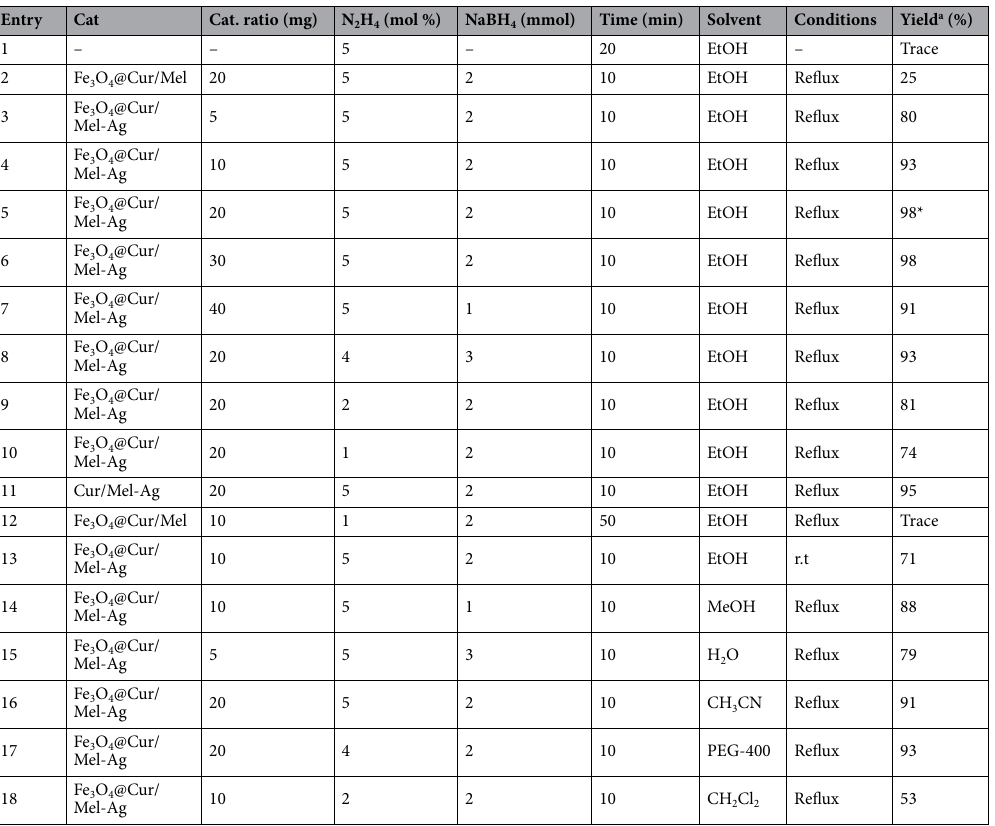
Table 1. Optimization of the NB reduction reaction conditions by applying various amounts of nanocomposite and hydrazine in various solvents and conditions. a Isolated yields. *Opimized